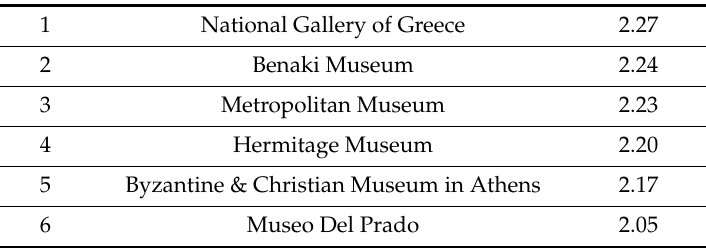
Table 3. The final ranking of the websites based on the values calculated by simple additive weighting (SAW) and presented in F SAW